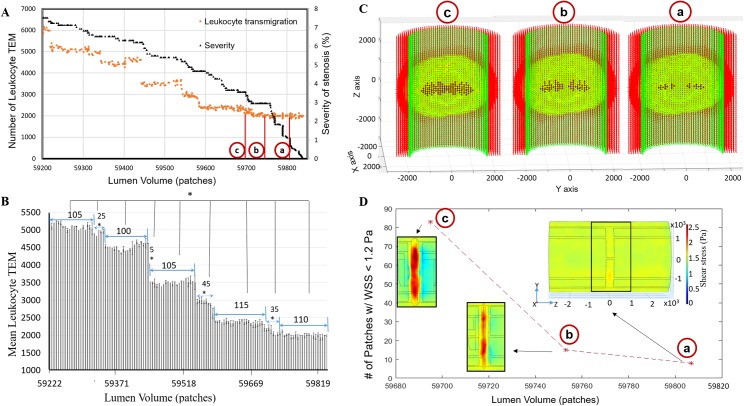
When the degree of stenosis was below 8%, the level of leukocyte TEM was constant over an average change in lumen volume of 107±5 patches, followed by a rapid increase in TEM over the next 28±17 patches.(A) Scatter plot displaying leukocyte TEM and severity of stenosis as a function of luminal volume (patches). (B) Bar plot indicating the change in lumen volume after which a significant increase in leukocyte TEM was observed. (Mean ± SD, *p < 0.05). (C) Longitudinal cross sections of the ABM at ‘a’, ‘b’, and ‘c’ points from 5A, illustrating where the initial inward growth occurred. ACs, ECs, and leukocytes in the plaque are indicated in red, green and yellow, respectively. Black represents the new ECs added in the lumen. Inlet flow is at the bottom of each subfigure. (D) Subplot showing the number of patches (from ABM) with WSS < 1.2 Pa at specific plaque shapes (i.e., lumen volumes) corresponding to ‘a’, ‘b’, and ‘c’ points from 5A. Overlaid color contour plots of the WSS (from CFD) over the plaque at each point. The number of patches of low WSS (blue region) are almost constant (13 and 15 respectively) corresponding to nearly constant TEM. Then, the number of patches having low WSS increases (83) as does TEM. Inlet flow is at the left of each subfigure in (D).